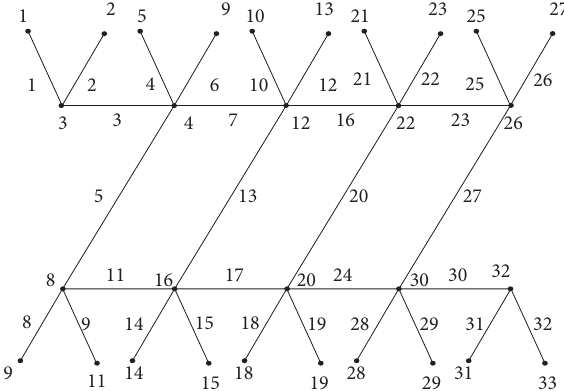
Figure 14: A classical mean labeling of SL